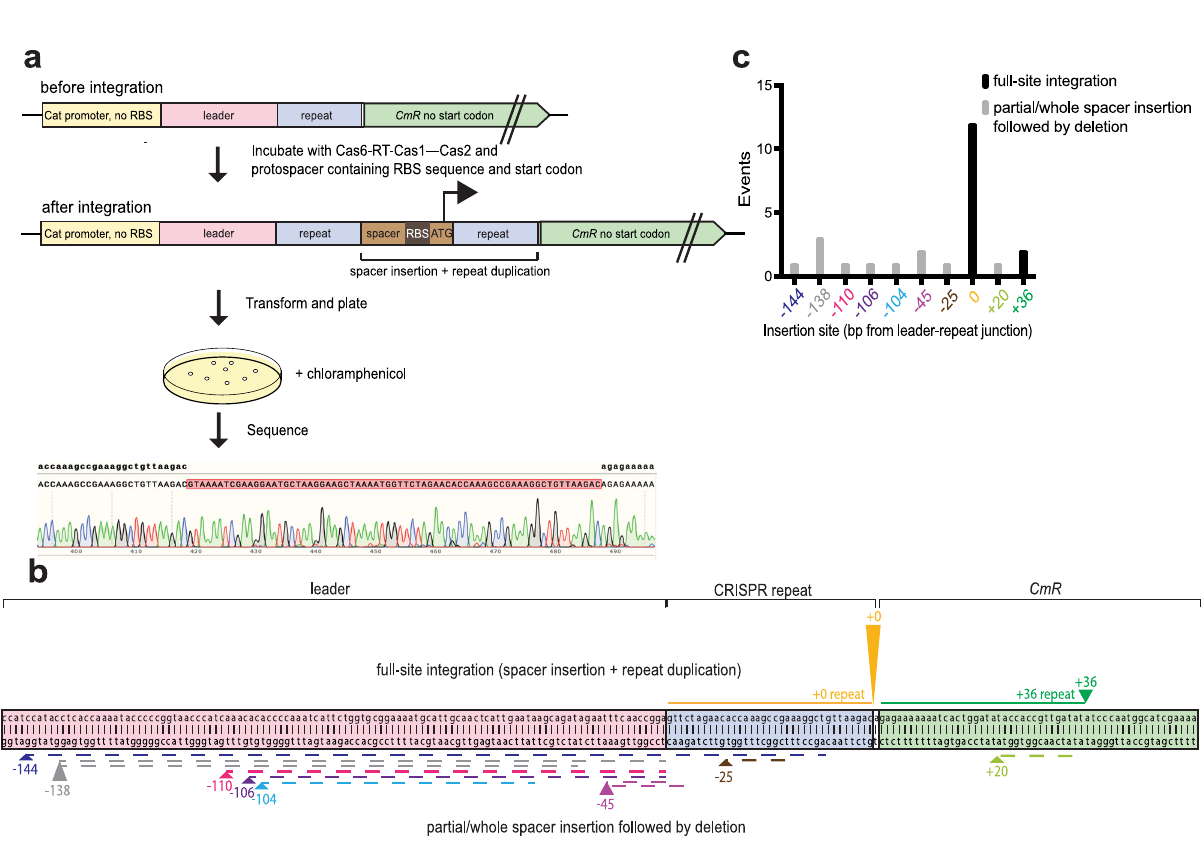
Fig. 4 Cas6-RT-Cas1 — Cas2 conducts site-speci fi c full-site integration. a Schematic of chloramphenicol selection screen for full-site integration events near the leader-repeat junction. The selection plasmid contains a CRISPR leader (pink) and repeat (blue) upstream of a chloramphenicol resistance gene ( CmR ; green) with the RBS and start codon removed. Full-site integration of a protospacer (brown) containing an RBS and start codon allows for translation of CmR . Transformants are plated on chloramphenicol plates and clones are sequenced using Sanger sequencing. b Representation depicting spacer insertion events near the leader-repeat junction in a selection plasmid with a 163 bp leader. The arrowheads indicate the insertion sites with number label indicating bp away from spacer-end of repeat (color-coding: + 0, yellow; − 25, brown; − 45, magenta, − 104, light blue; − 106, purple; − 110, pink, − 138 gray; − 144, dark blue; + 20, light green; + 36, dark green) and the height is scaled to the number of spacer insertion events. The arrows on top indicate full-site integration events, with the corresponding solid colored line adjacent to the arrowhead representing the sequence that is duplicated after spacer insertion. The arrows on the bottom indicate partial/whole spacer insertion events followed by a deletion, with the corresponding dashed colored line adjacent to the arrowhead representing the sequence that is deleted with the spacer insertion. c Number of spacer insertion events near the leader-repeat junction. Insertion sites follow color-coding in b . The black bars represent full-site integration events with a 35 bp repeat duplication of the adjacent sequence and the gray bars represent partial/whole spacer insertion followed by a deletion of variable length. Source data for panel c are provided as a Source Data fi